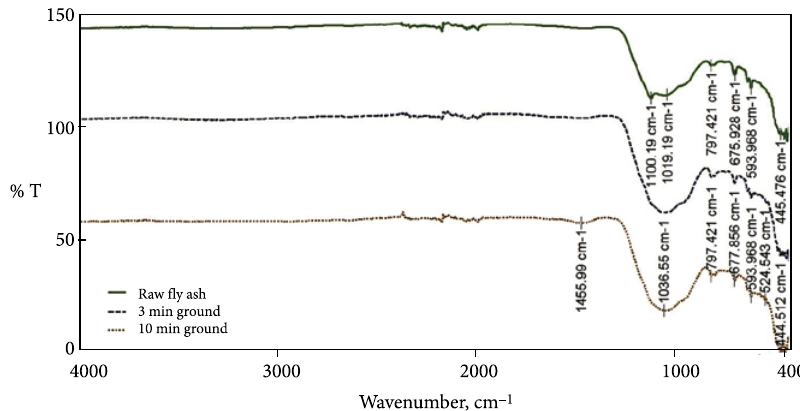
Fig. 4. FT-IR spectras of raw fly ash and mechanically activated fly ash for 3 and 10